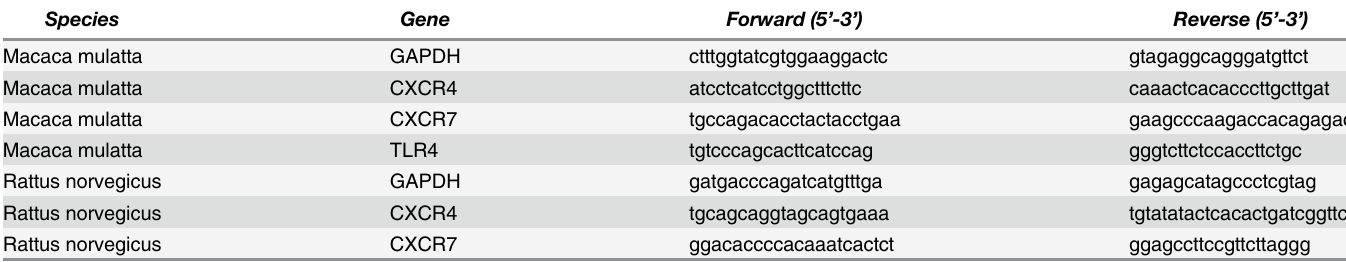
Table 1. Primer pairs used for